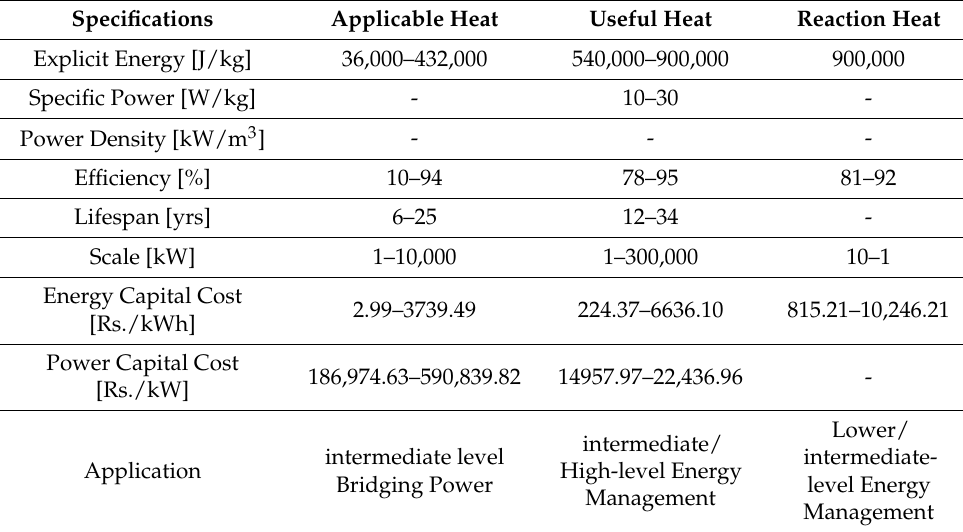
Table 2. Diverse thermal energy storage